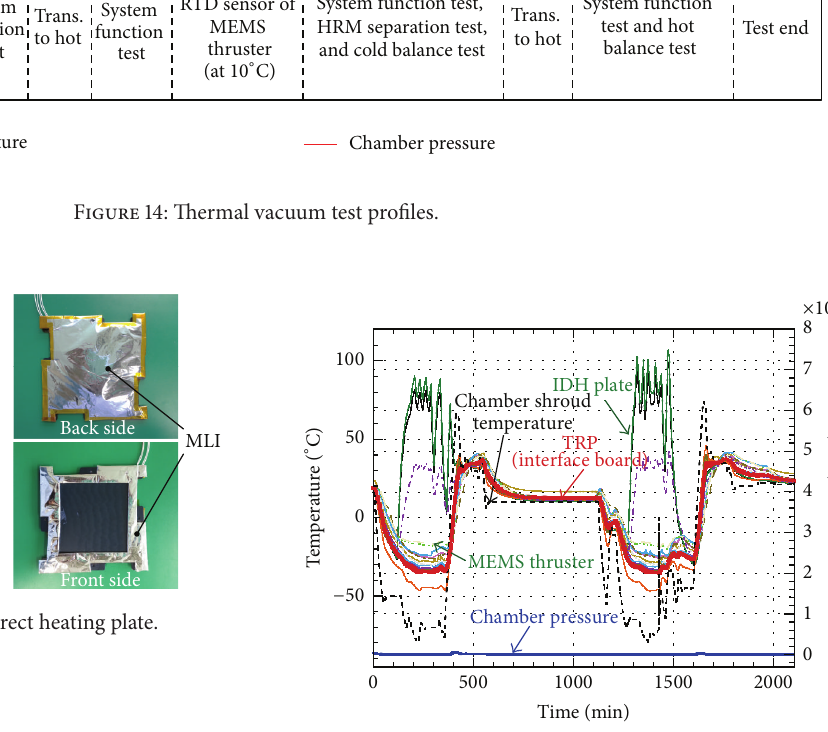
Figure 16: Temperature profiles of all equipment obtained from TV